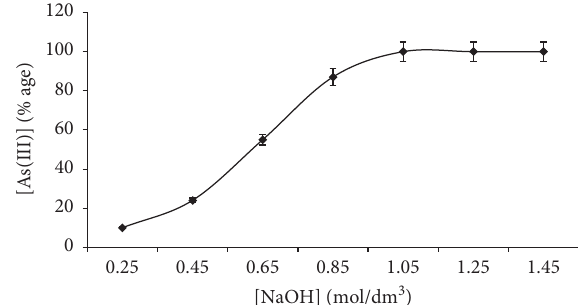
Figure 6: Effect of NaOH concentration on transport of As (III). [HCl] in feed solution � 0.67mol/dm 3 , [TDDA] in membrane phase � 0.63mol/dm 3 , [NaOH] in stripping solution � 0.25mol/ dm 3 to 1.50mol/dm 3 , [As (III)] � 8.6019 × 10 − 4 mol/dm 3 , [H 2 O 2 ] � 10 − 7 mol/L, time � 4.0 h.